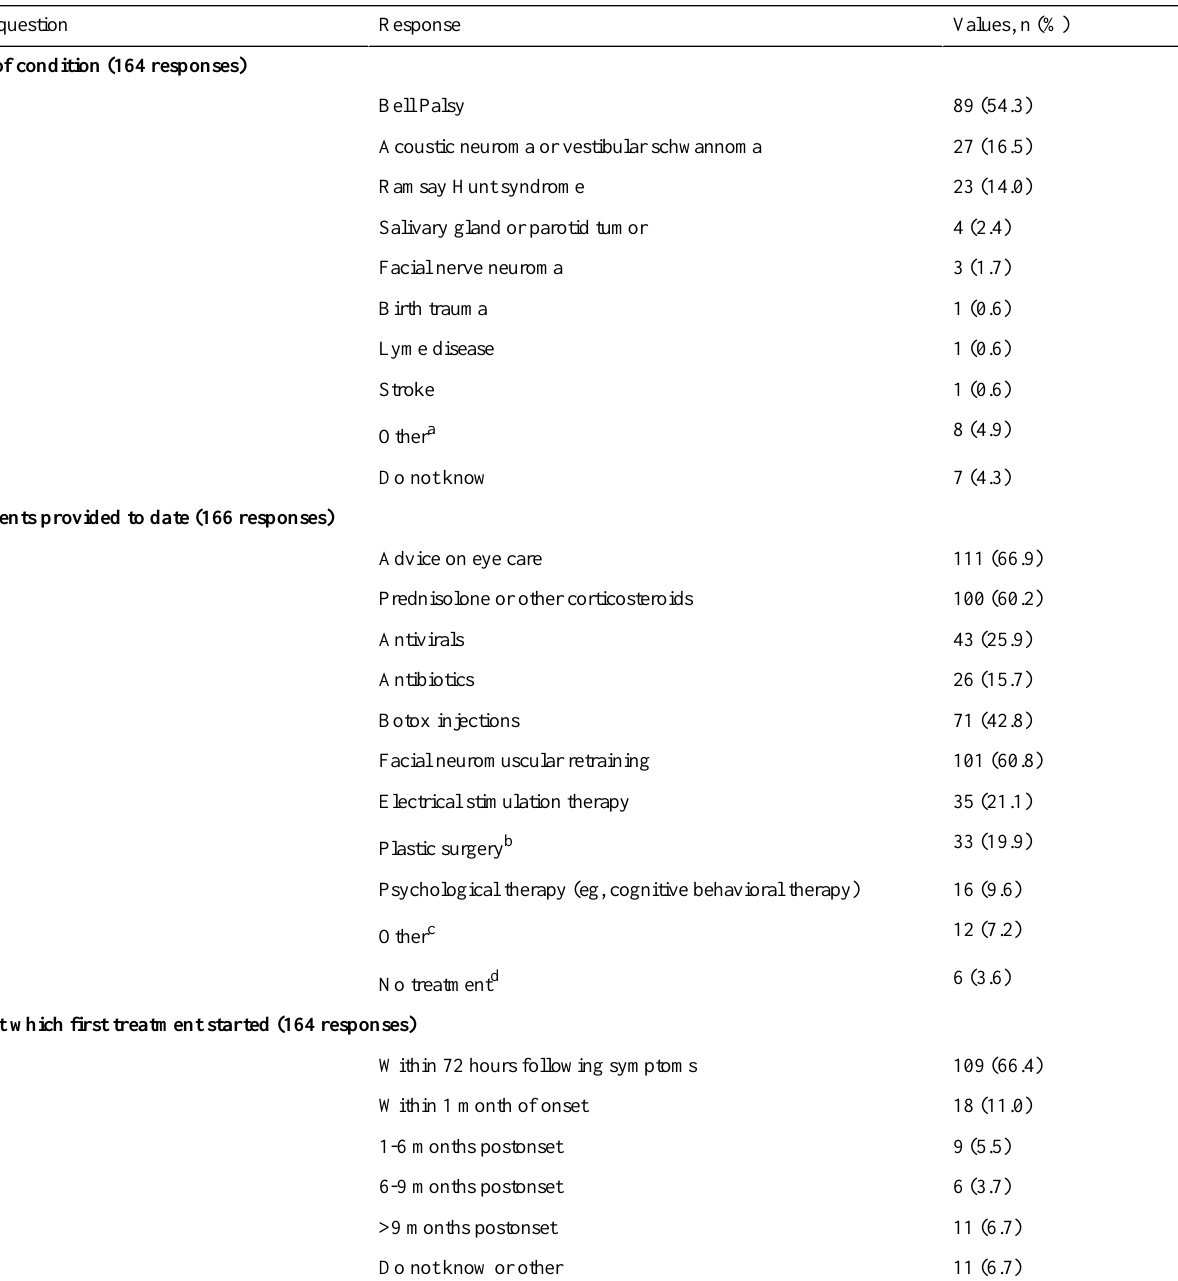
Table 1. Patients in the United Kingdom with adult-acquired facial nerve paralysis: reported diagnosis and treatment pathways (n=167).